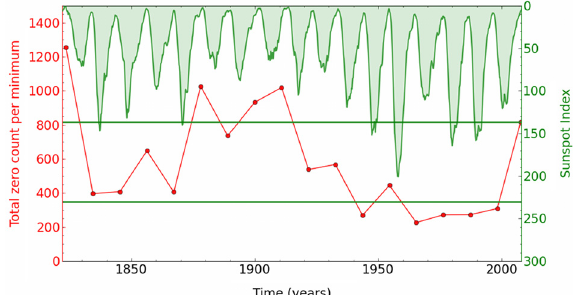
Fig. 4. Plot of the total number of spotless days during each solar cycle minimum since 1820, i.e., over the period when the index is available for all days (red curve). For comparison, the monthly average sunspot index R i is plotted in a reversed vertical scale (green curve), showing the global anticorrelation between spotless days and the global trend in sunspot cycle amplitude. The green horizontal marker lines help us to see that several other minima largely exceeded the last minimum in terms of spotless days, in particular the leftmost one that corresponds to the end of the Dalton minimum. They also show that the four recent minima (19–22) had consistently very low values without equivalent over at least the last 200 years.